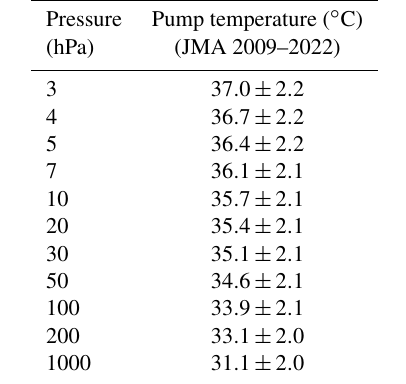
Table 1. Pump-temperature measurement results for Sapporo, Tateno, and Naha from 2009 to